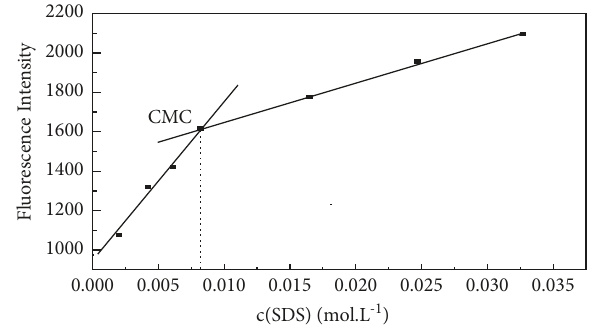
Figure 3: Plot of fluorescence intensity versus SDS concentration at 298